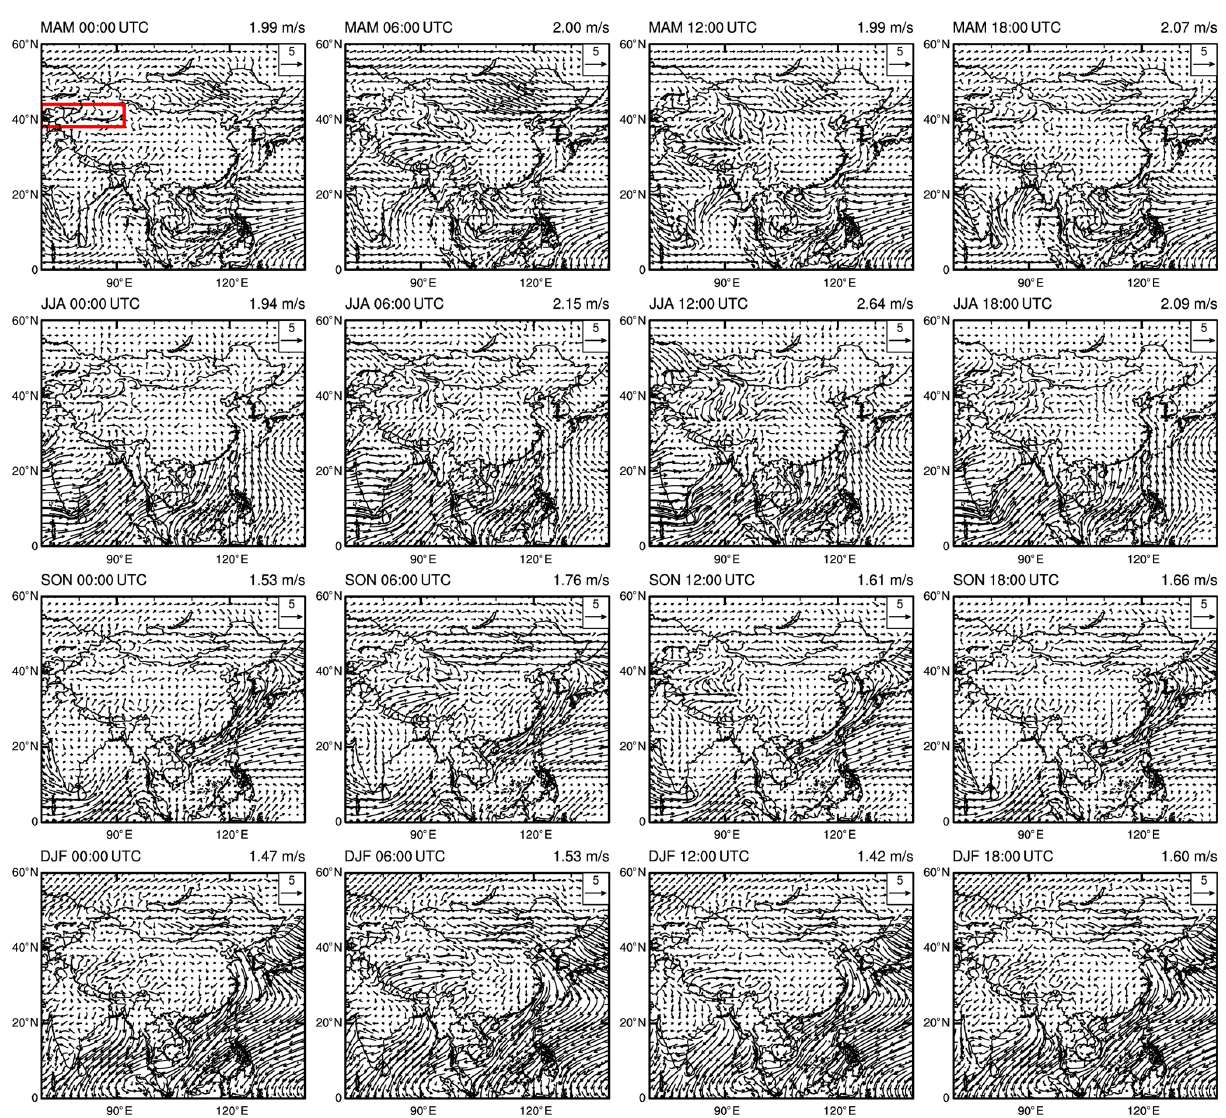
Figure 8. Spatial distributions of the annual mean 10m wind fields 6h from the NCEP FNL reanalysis data. The value in the top right-hand corner represents the regional mean 10m wind speed in the red